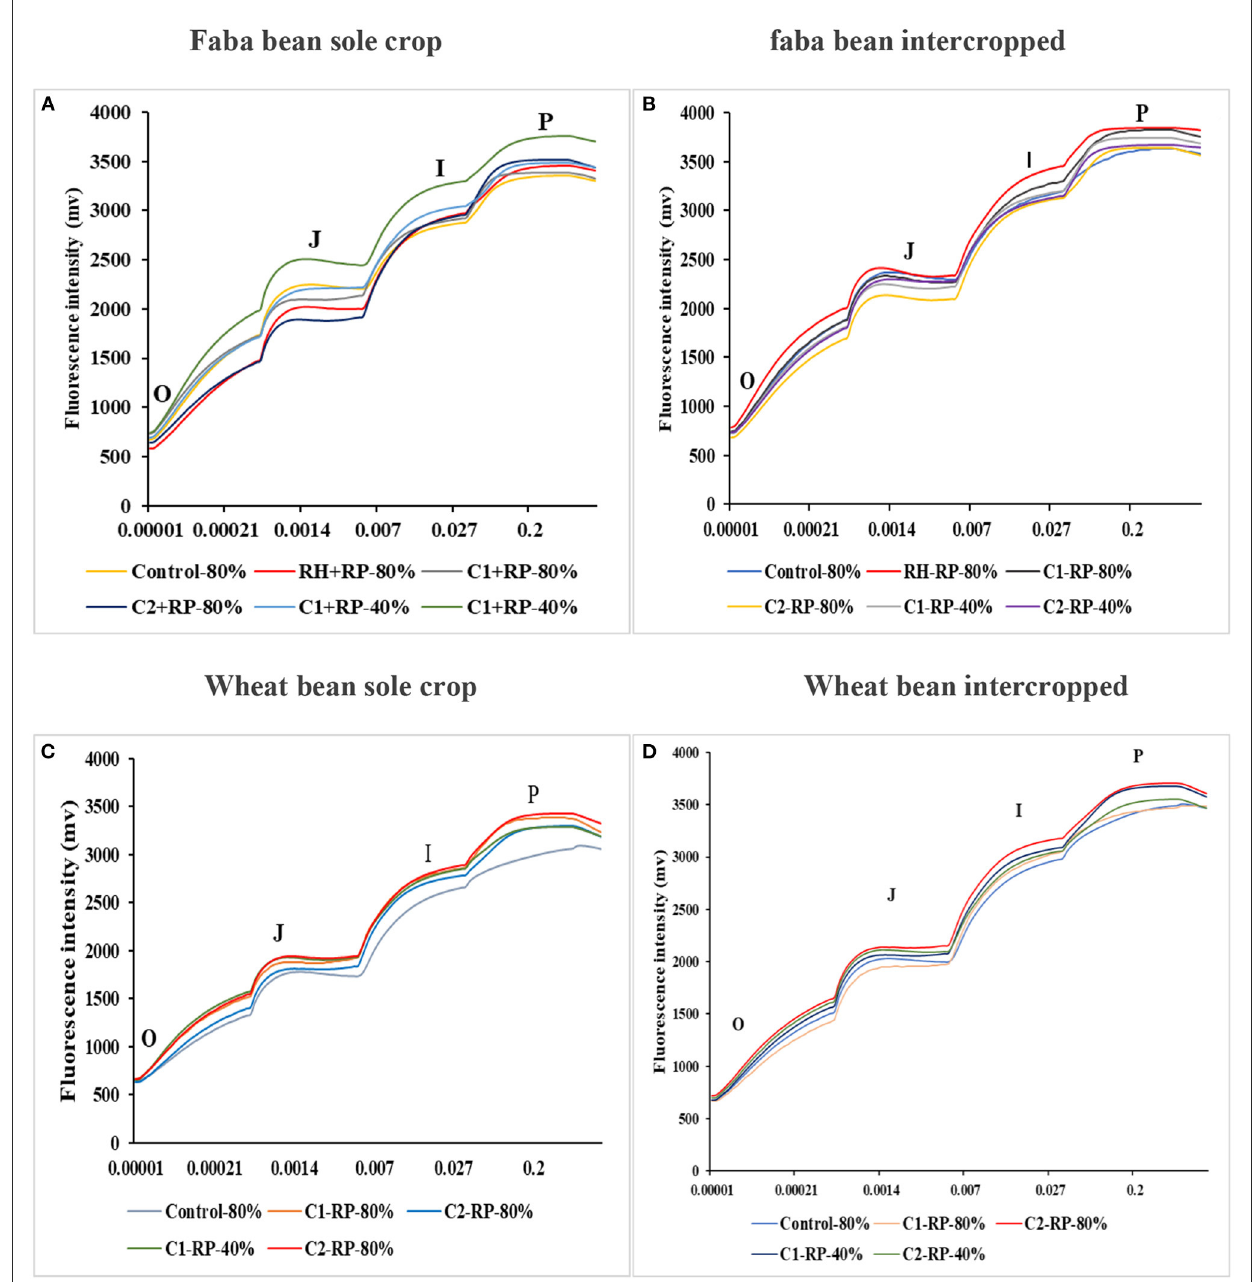
FIGURE6 Faba bean sole crop chlorophyll “a” polyphasic fluorescence OJIP (A) , Faba bean intercropped chlorophyll “a” polyphasic fluorescence OJIP (B) , wheat sole crop chlorophyll “a” polyphasic fluorescence OJIP (C) , wheat intercropped chlorophyll “a” polyphasic fluorescence OJIP (D) , under water sufficiency and P limitation (80% WHC, RP) vs. combined water deficit and P limitation (40% WHC, RP), and inoculated with two rhizobacterial consortia (C1 and C2) containing rhizobia and two PGPRs. The positive controls were supplemented with 125 µ mol/l of KH 2 PO 4 and 46 mg/l